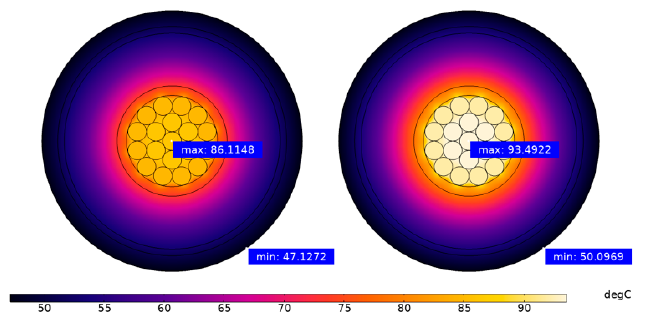
Figure 10. Distribution of the temperature field in °C when the conductor is mechanically damaged ( left 140%; right 168%).